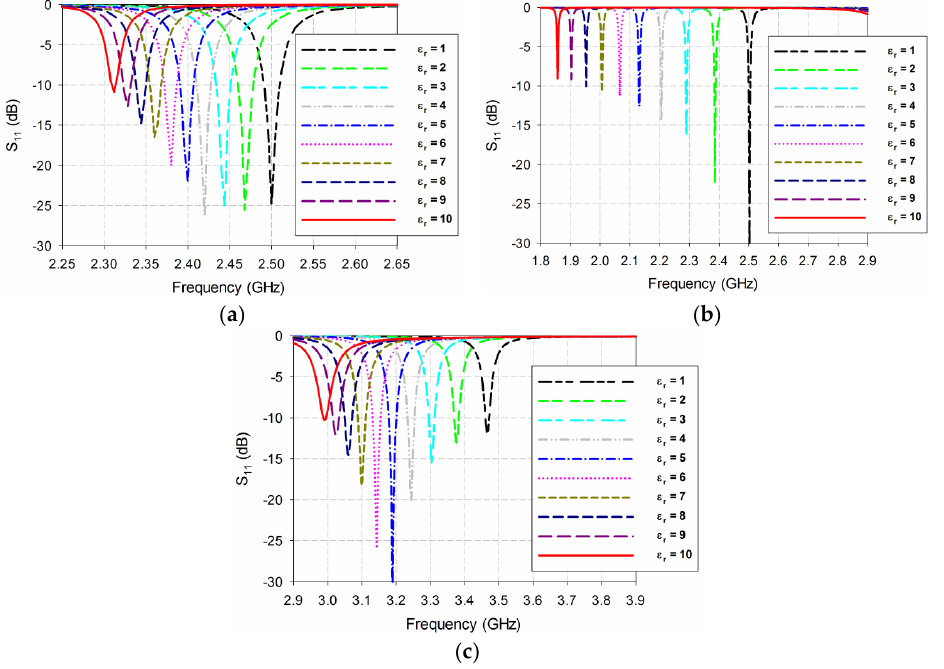
Figure 5. S 11 characteristics of the conventional and proposed patch antennas when varying relative permittivity of the MUT: ( a ) Conventional f r1 ; ( b ) proposed f r1 ; ( c ) proposed f r2 . Table 1. Resonant frequencies of S 11 responses of the conventional and proposed patch antennas in GHz.